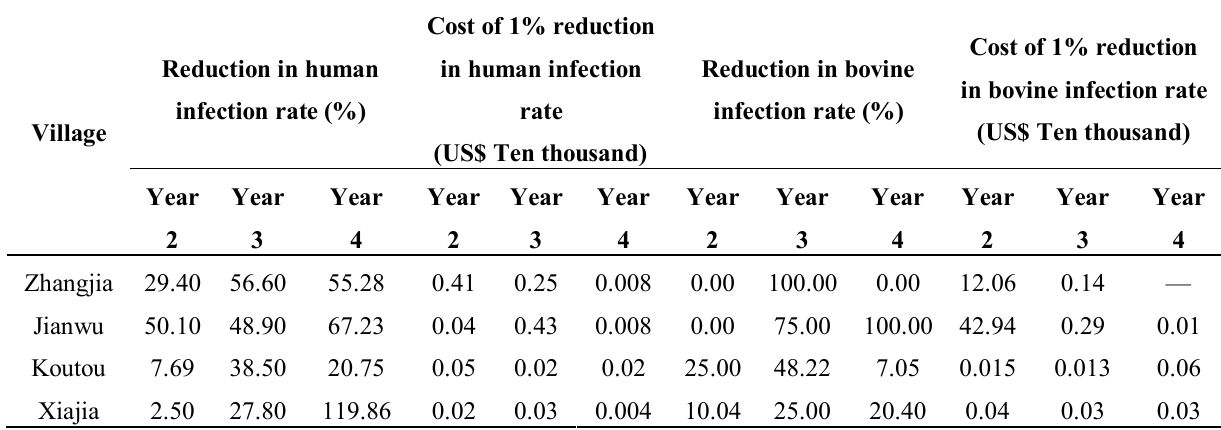
Table 8. Cost-effectiveness analysis for four